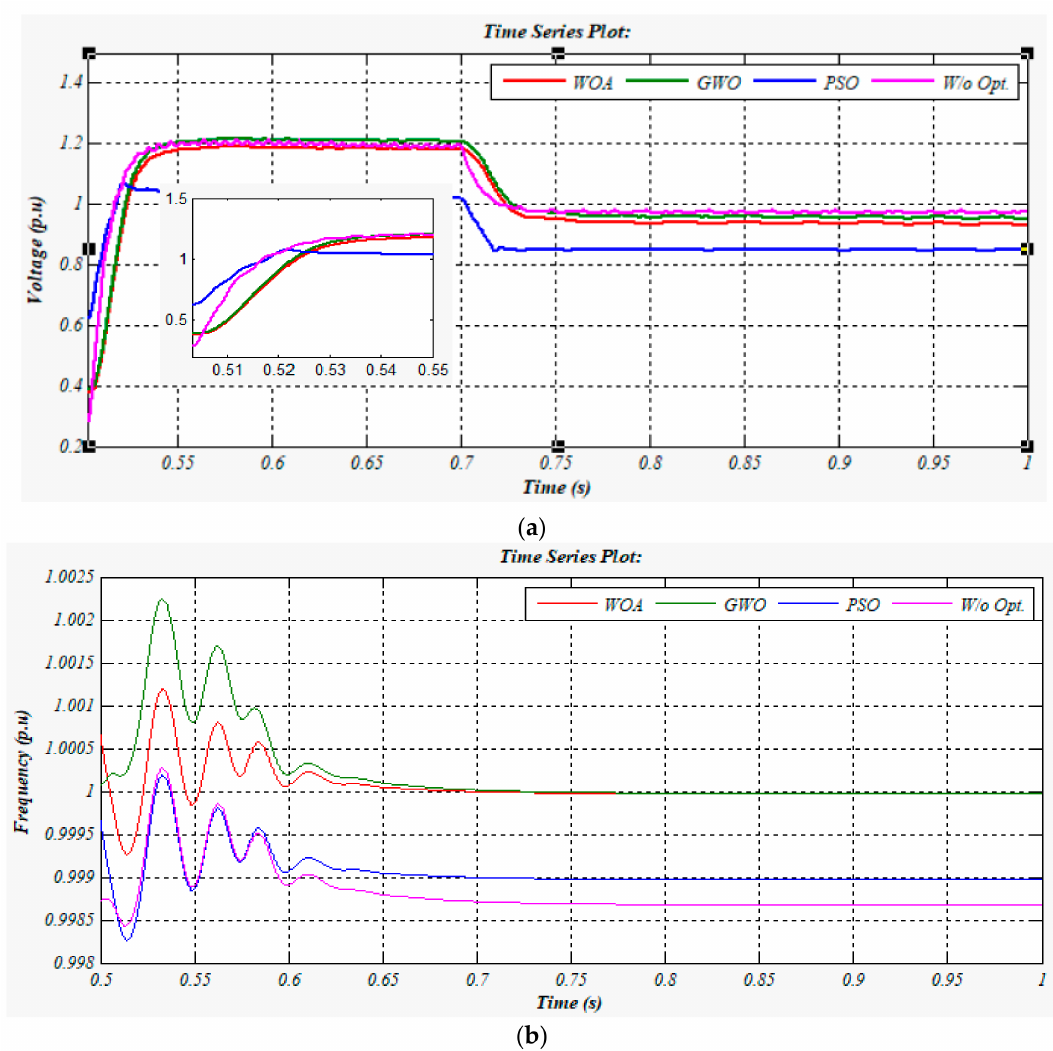
Figure 7. Simulation results during change of MG operating mode. ( a ) System Voltage Response. ( b ) System Frequency Response.